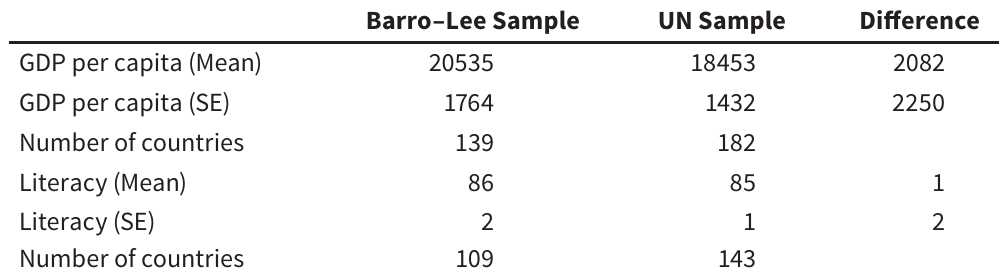
Barro–Lee Sample Compared to UN Member State